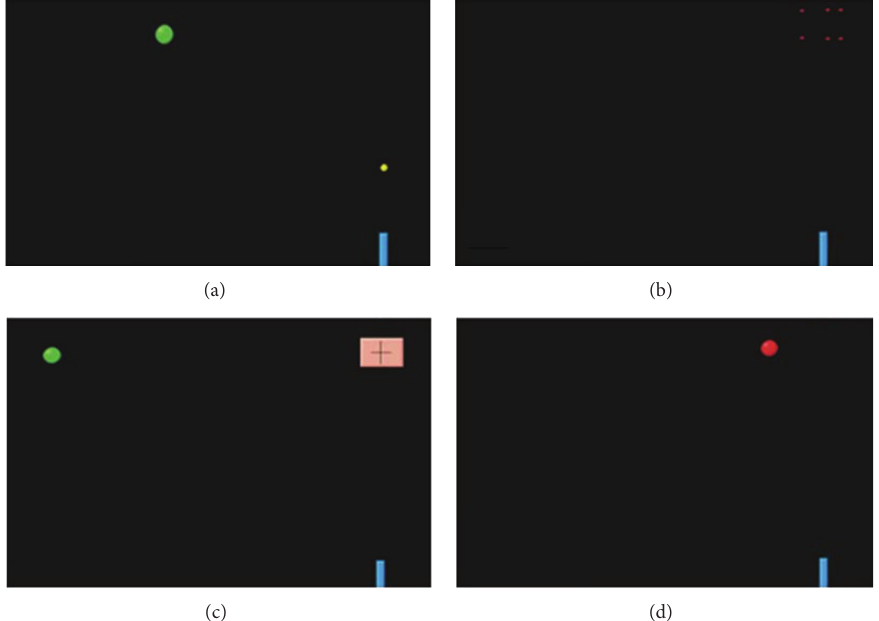
Figure 1: The task and experimental conditions. (a) The main interception task. The green ball moves from the left side of the screen to the interception zone in the upper right corner of the screen (as for the position, corresponding to the pink cross square in Figure 1(c)). The blue “gun” in the lower right corner fires a “projectile” travelling at a constant speed to intercept the green ball. (b) Successful hit. If the ball is intercepted by the projectile, both objects explode. In case of miss, there is no animation. (c) Control condition 1. There is no projectile in this condition. The subject is supposed to press the button at the very moment the green ball reaches the interception zone marked by the cross inside the pink square. If the subject is successful, the ball explodes. (d) Control condition 2: the green ball once again moves from the left side of the screen to the interception area. However, there is no gun/projectile or pink interception square. The subject is supposed to press the button as soon as the ball changes its color from green to